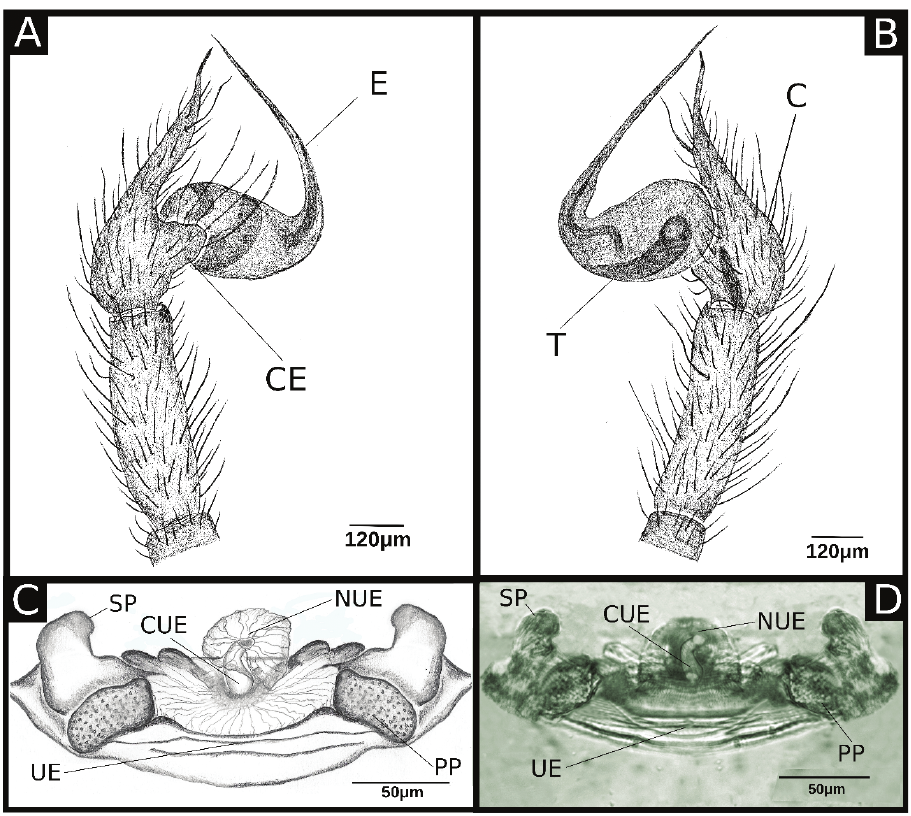
Figure 13. Ochyrocera rosinha sp. nov., A left male palp (IBSP 196441), retrolateral view B same, prolat- eral C female genitalia (UFLA 60680), dorsal view D same, enzyme cleared, dorsal view. Abbreviations: C, cymbium; CE, cymbial extension; CUE, columnar uterus externus; E, embolus; NUE, neck of uterus externus; PP, pore-plate; SP, spermathecae; T, tegulum; UE, uterus